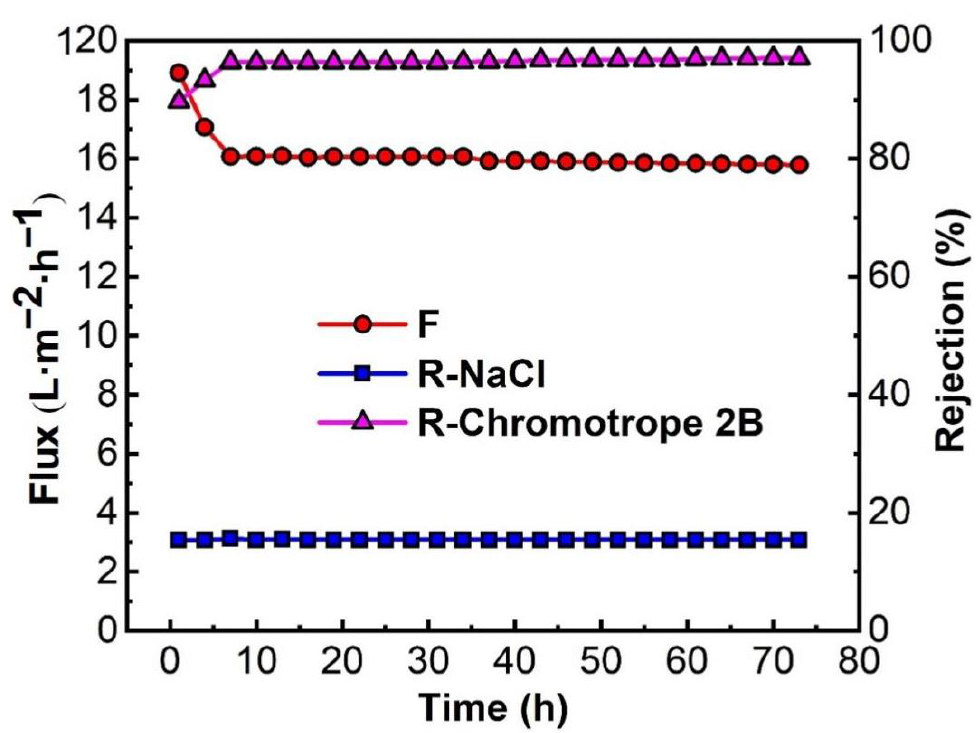
Figure 11. Continuous stable operation test of the PMIA HF NF membrane. Test conditions: 100 ppm chromotrope 2B and 4000 ppm NaCl, 0.35 MPa, 25 ± 1 °C.